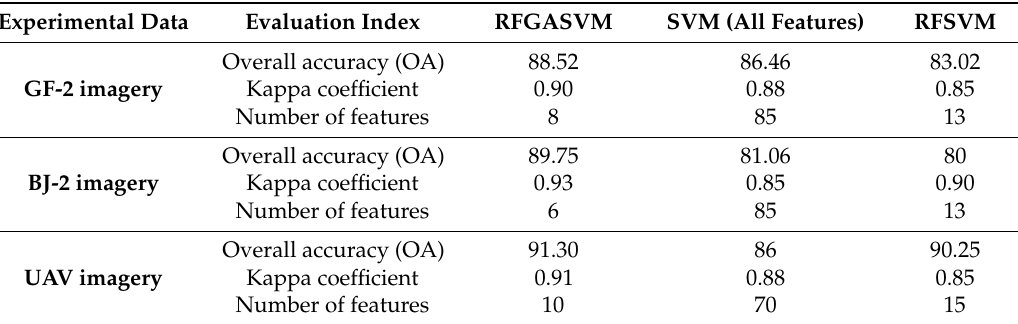
Table 5. Comparison among RFGASVM and related methods.